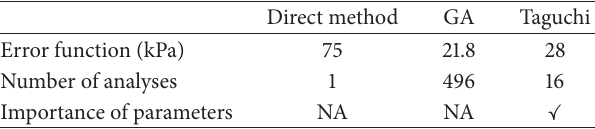
Table 10: Comparison of used